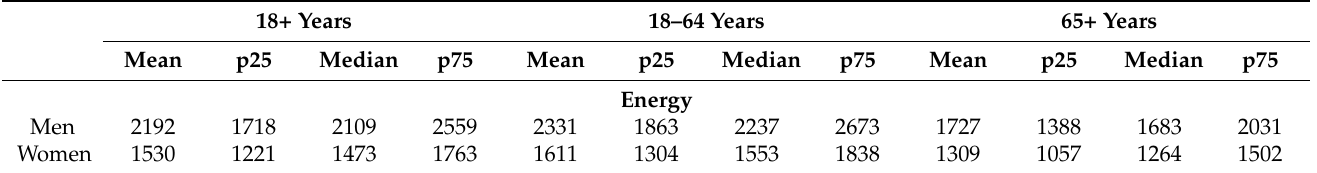
Table 2. Mean, median, and percentiles (25th and 75th) distribution † of the usual daily energy intake (kcal) in the Greek National Health and Nutrition Survey—HYDRIA.